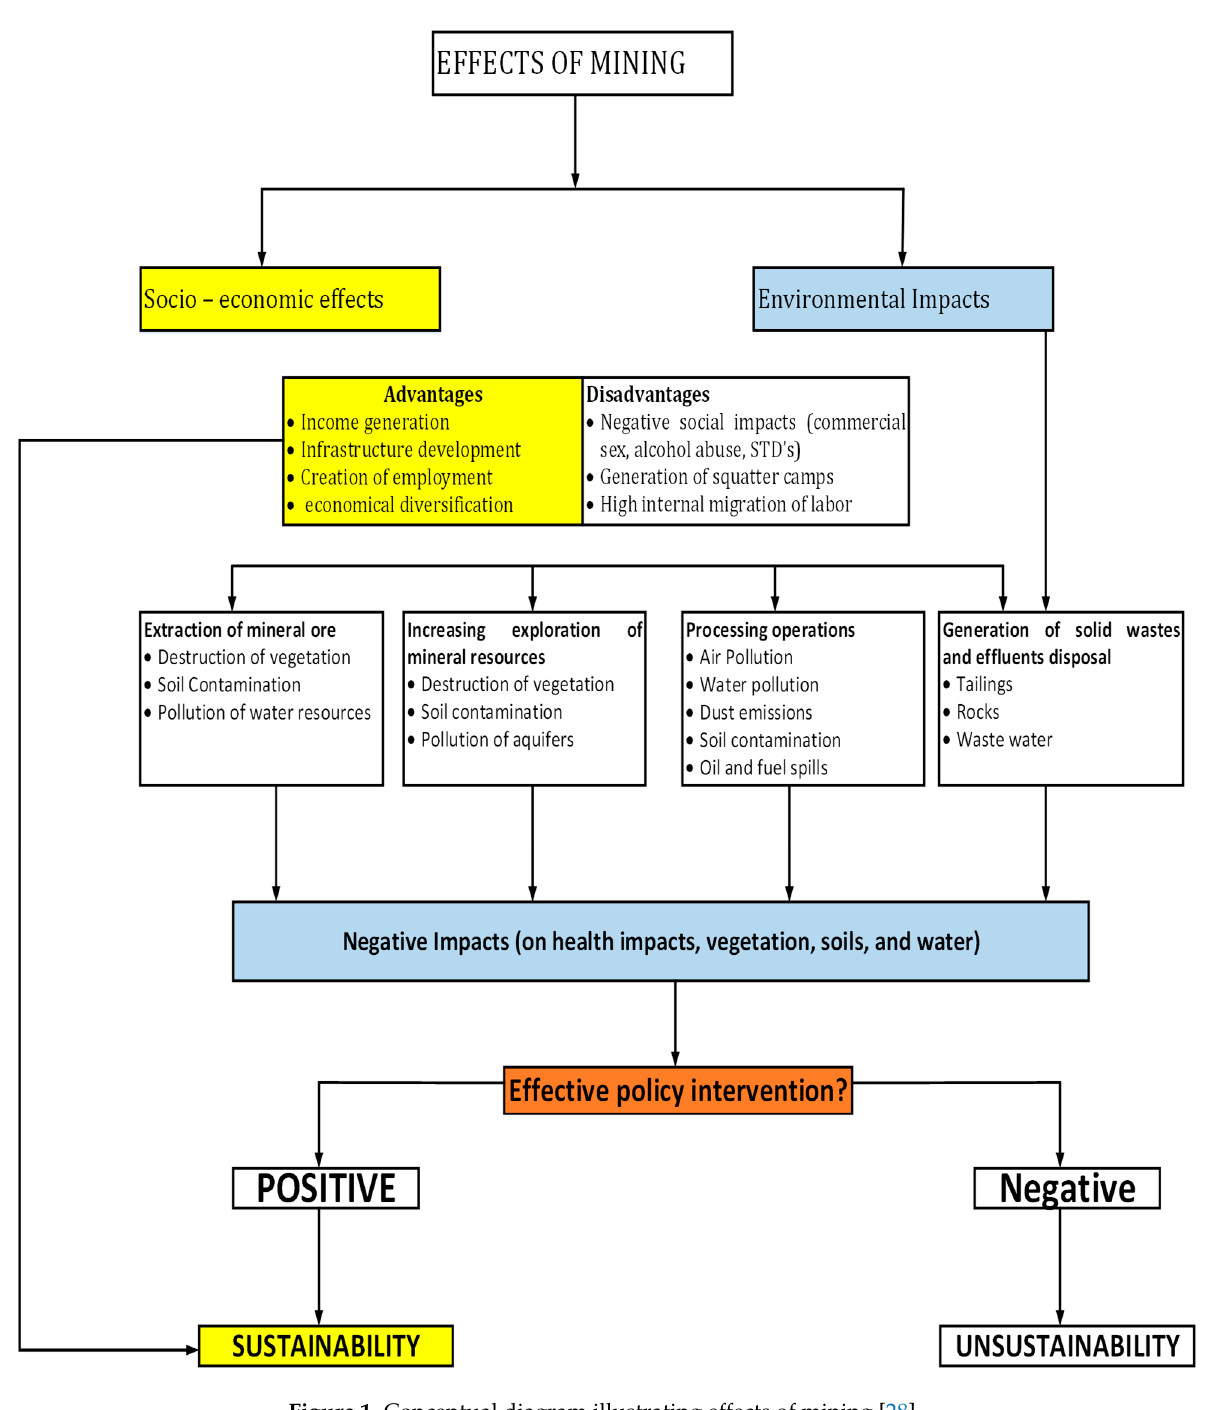
Figure 1. Conceptual diagram illustrating effects of mining [28]. Most of the phases in copper- and nickel-bearing ores are bornite, chalcopyrite, and chalcocite, which can be quantified using QEMSCAN. Copper slag following the pro- duction of copper and nickel includes phases such as Cu–Fe–S [19]. Table 1 shows the chemical composition of copper slag. The mechanical and physical properties of slags differ depending how the slag was cooled with most of slag having a unit weight ranging between 2800–3800 kg/m 3 , Bulk density between 144 × 162 Ib per cubic feet,